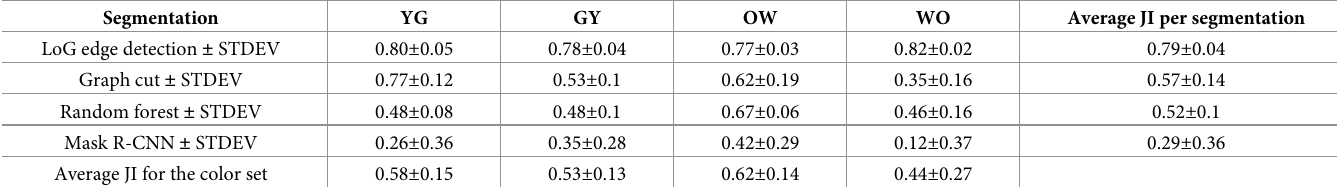
Average JI for the color set The presented values of Jaccard index are the means of the individual indexes obtained for the individual image ± Standard deviation (STDEV). The augmented images set consists of the images with the foreground taken from the other color set: the letters in abbreviation correspond to the color first letter from where the foreground and the background, respectively was used for making the augmented